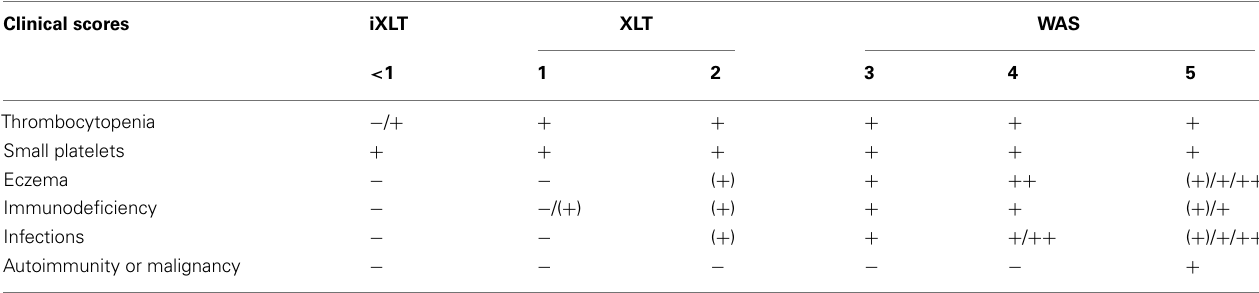
Table 1 |WAS scoring system according to Zhu et al. (1997), with subsequent refinements (Ochs andThrasher, 2006; Ochs et al., 2009). Clinical